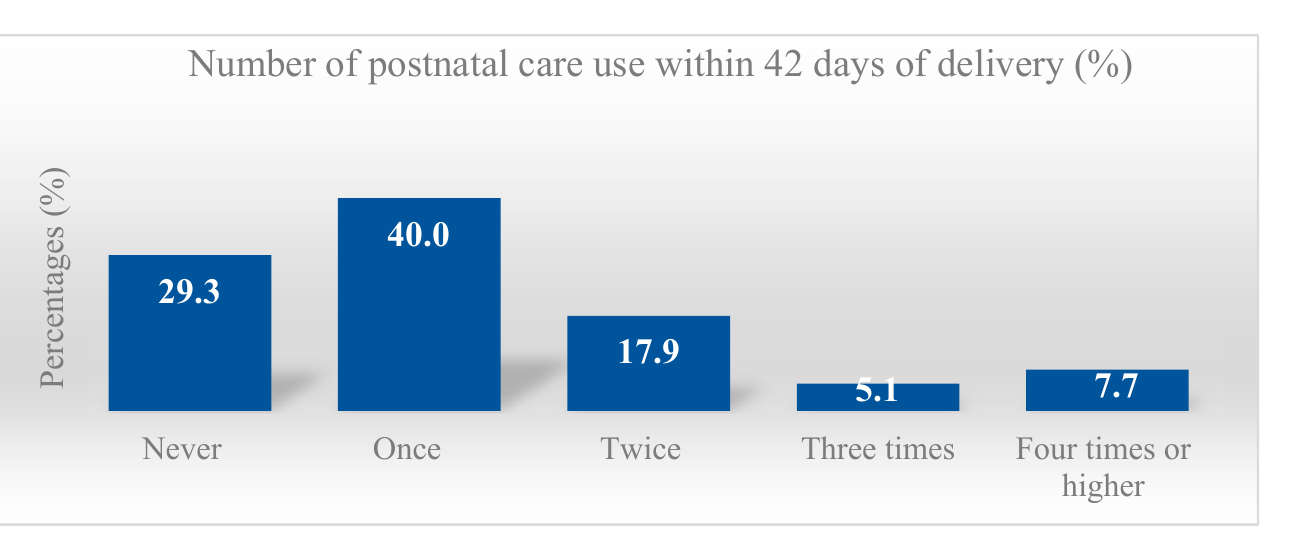
Figure 1. Percentage distribution of postnatal care use among postpartum women aged 18–49 years old at up to six months postpartum in Thailand during the COVID-19 pandemic.